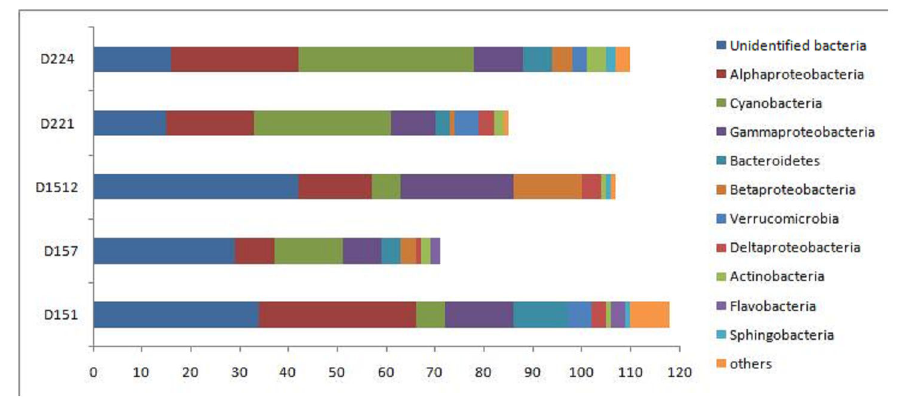
Figure 2. The spatial profiles of the bacterial community structure based on 16S rRNA gene clone libraries from the five sampling sites. D151, samples collected from D151 site; D157, samples collected from D157 site; D1512, samples collected from D1512 site; D221, samples collected from D221 site; D224, samples collected from D224